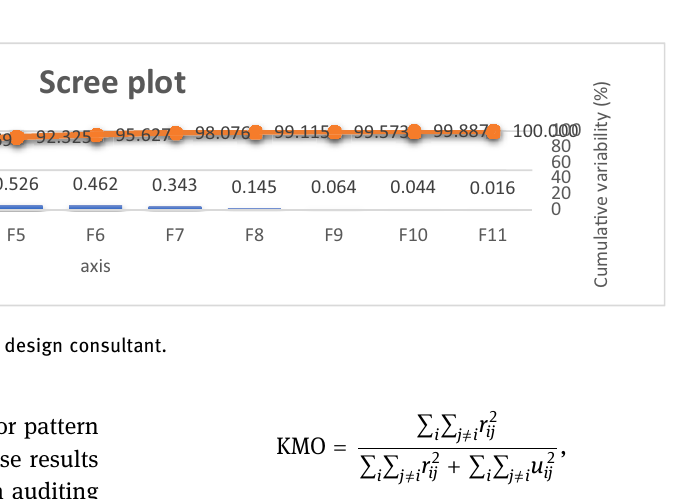
where R = r ij is the correlation matrix; and U = [ u ij ] is the partial covariance matrix.